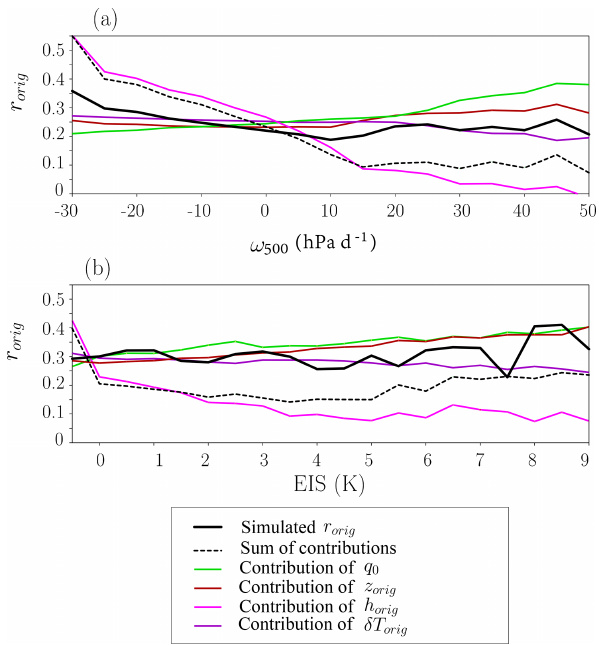
Figure 10. Composites as a function of ω 500 (a) and of EIS (b) of the seasonal averages of r orig simulated by LMDZ over all tropi- cal ocean locations (black). Same for the sum of the contributions (black dashed) and for each individual contribution to r orig : q 0 varies (green), z orig (dark red), h(z orig ) (pink), and δT orig (purple). The number of samples in each bin is indicated on a logarithmic scale on the right-hand side as bars.